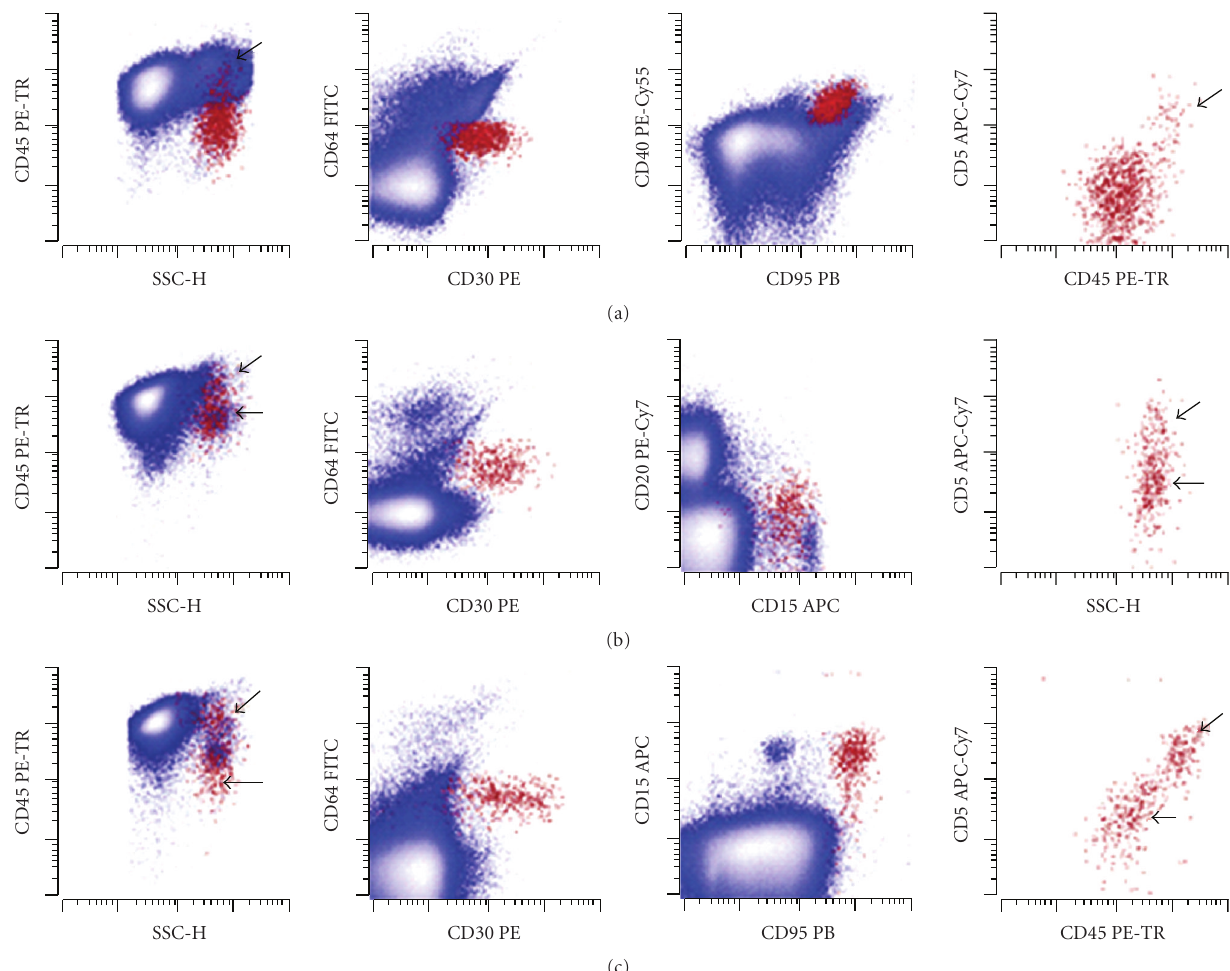
Figure 2: Clinical cases of CHL can demonstrate varying proportions of HRS cells rosetted by CD5+ T cells that also increase the apparent CD45 expression level of the rosetted HRS cells. Representative examples of flow cytometric immunophenotyping of lymph nodes involved by CHL using the single tube, 9-color assay are shown. HRS cells (shown in red and emphasized) are identified by their expression of CD30, CD40, CD95, absence of expression of CD64, and increased side light scatter (SSC-H) compared to normal lymphocytes; all remaining viable events are in blue. Oblique and horizontal arrows denote rosetted and unrosetted HRS populations, respectively. Dot plots at the end of panels demonstrate HRS cells in isolation for clarity. (a) Neoplastic unrosetted HRS cells have expression of low CD45, intermediate CD30, and bright CD40 and CD95, without expression of CD64 (position of negative determined by isotype-matched control experiment, data not shown), CD5, CD15 (data not shown), or CD20 (data not shown). The small, T-rosetted population of HRS has increased CD45 and expression of CD5 (oblique arrow). (b) Neoplastic unrosetted HRS cells have expression of intermediate CD45, intermediate to bright CD30, CD40 (data not shown) and CD95 (data not shown), and intermediate CD15, without expression of CD5, CD64, or CD20. The small rosetted population has expression of CD5 and increased CD45. (c) Neoplastic unrosetted HRS cells have expression of low to intermediate CD45, variable intermediate to bright CD30, bright CD40 (data not shown) and CD95, intermediate CD15, and variable CD71 (data not shown), without expression of CD5, CD64, or CD20 (data not shown). The rosetted population has increased CD45 and expression of CD5. ( c (cid:2) Modified from 2009 American Society of Clinical Pathology